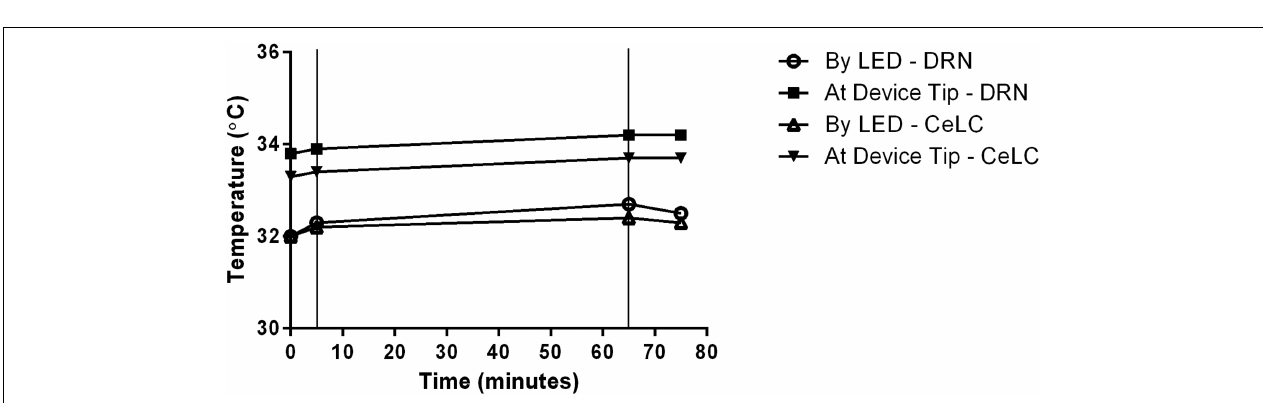
FIGURE 5 | Recorded change of DRN and CeLC temperatures during implantation. Temperature readings were done in the vicinity of the implanted devices, specifically by the LED and at the device insertion tip. Thin vertical lines in the graph indicate start and end points of LED activation time.